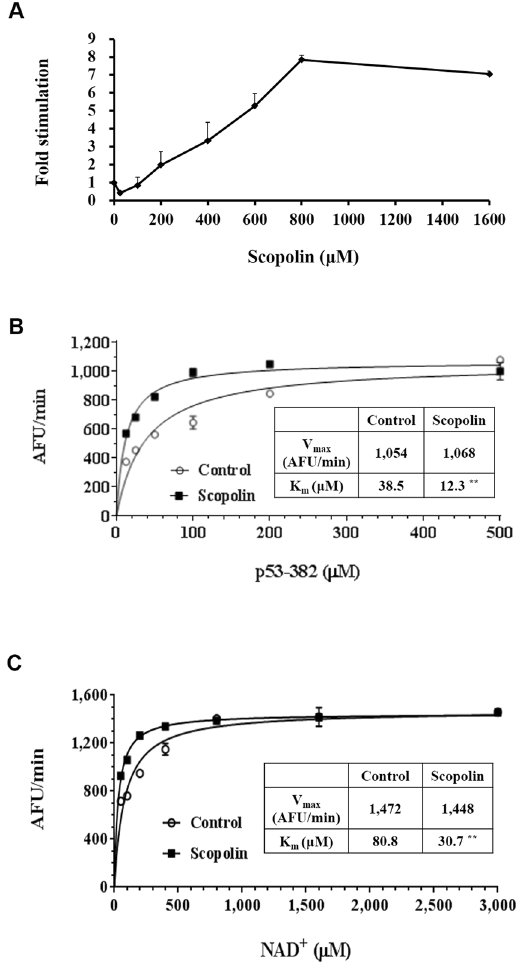
Figure 4. Scopolin activates SIRT1 by decreasing its Km. ( A ) Scopolin dose-response curve of the SIRT1 catalytic rate. ( B ) SIRT1 initial rate with 3 mM NAD + , as a function of the p53-382 acetylated peptide concentration in the presence (open circles) or absence (closed squares) of 800 μ M scopolin. Lines represent nonlinear least-squares fits to the Michaelis-Menten equation. Km (control, open circles) = 38.5 μ M, Km (plus scopolin, closed squares) = 12.3 μ M; Vmax (control, open circles) = 1,054 AFU/min, Vmax (plus scopolin, closed squares) = 1,068 AFU/min. ( C ) SIRT1 initial rate at 500 μ M p53-382 acetylated peptide, as a function of the NAD + concentration, in the presence (open circles) or absence (closed squares) of 800 μ M scopolin as in ( B ). Km (control, open circles) = 80.8 μ M, Km (plus scopolin, closed squares) = 30.7 μ M; Vmax (control, open circles) = 1,472 AFU/min, Vmax (plus scopolin, closed squares) = 1,448 AFU/min. Data represent means from three independent experiments. Different letters indicate statistical significance, p <